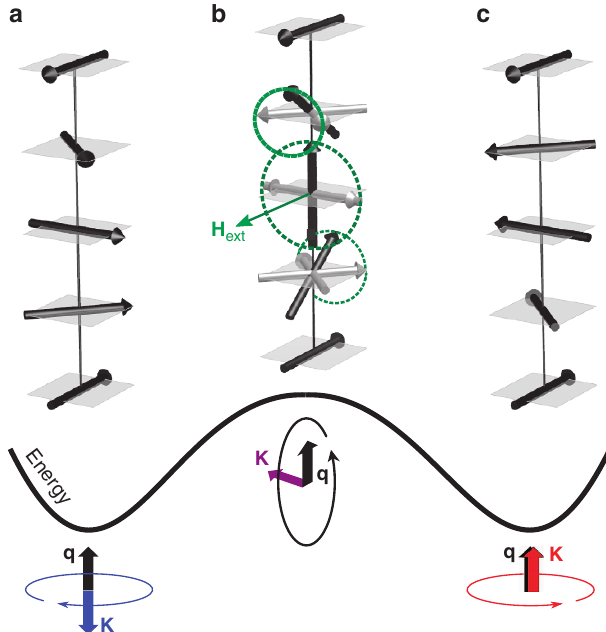
Figure 5 | Switching of the magnetic helicity using magnetic pulse. Application of the external magnetic pulse H ext (indicated by the green arrow) perpendicular to the spiral wave vector q causes the precession of local moments (rotating along the dashed green curves), which changes the helicity of a spiral from left-handed screw ( a ), through the intermediate cycloidal state ( b ) and to the right-handed screw ( c ). In the case of the easy-plane MCA, the long period of a spiral greatly facilitates reorientation of helicity from j mk q (blue) to j mm q (red) or vice versa, since the top of the energy barrier between two stable screws ( a , c ) is a cycloid ( b ) j > q (magenta), in which only few atomic planes with magnetic moments orthogonal to H ext acquire high